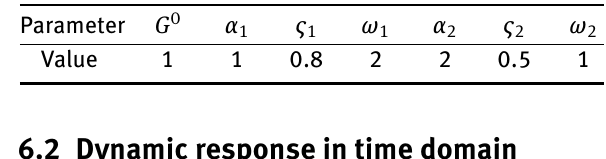
Table 3: Two-term GHM